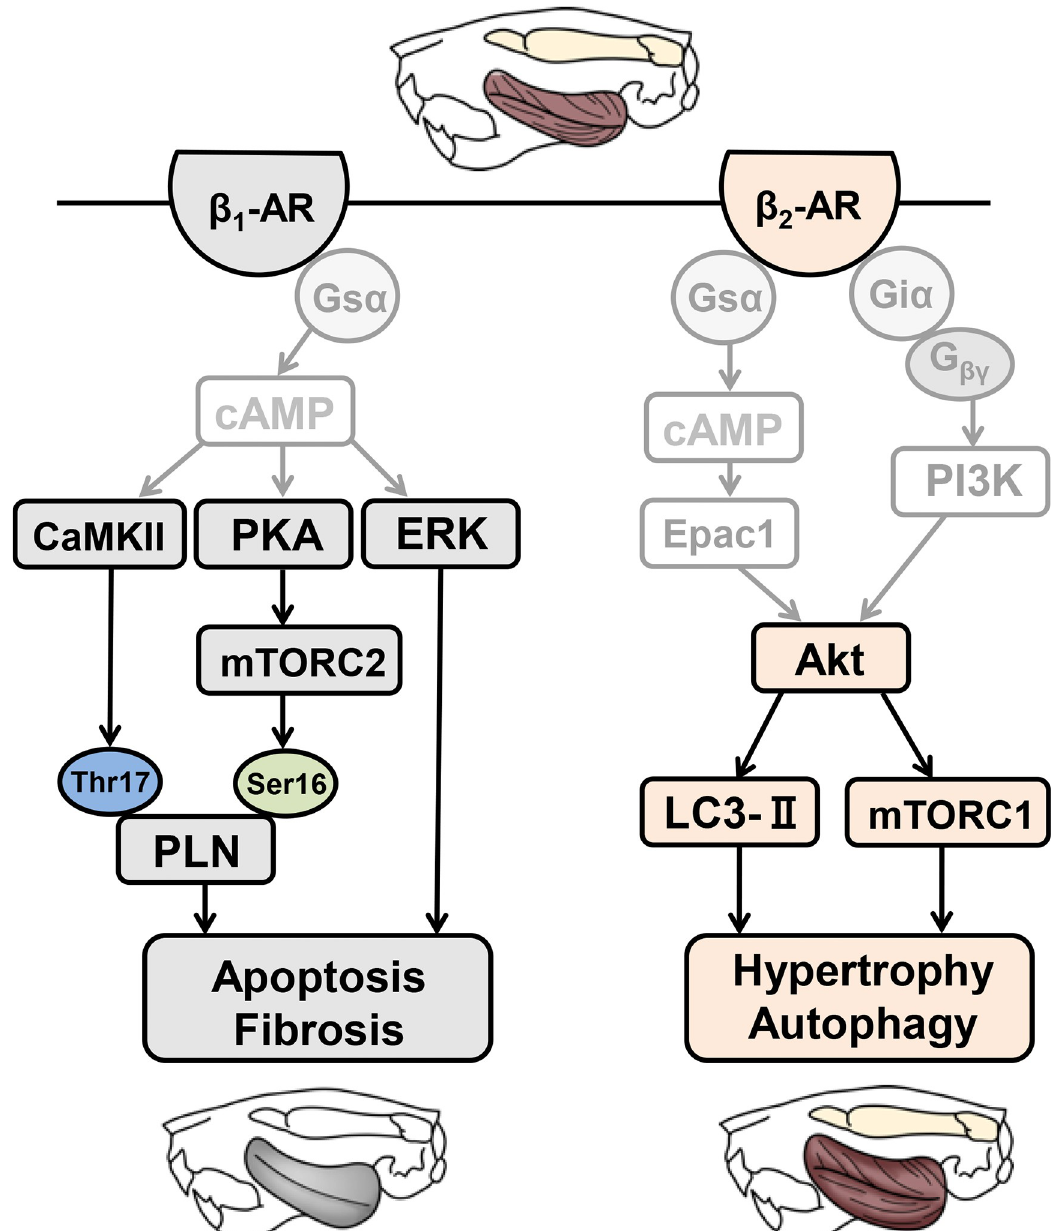
Fig 8. Schematic illustration of the proposed roles of β -AR signaling in masseter muscle. This scheme illustrates the proposed relationship of β 1 -AR and β 2 -AR signaling in masseter muscle. Chronic β 1 -AR stimulation with DOB induces muscle fibrosis and apoptosis with the increase of ERK1/2, CaMKII and mTORC2 activation ( left ). Chronic β 1 -AR stimulation with CB induces muscle hypertrophy and autophagy with increase of mTORC1 activation and LC3-II expression ( right ). Solid black lines represent findings in this study and solid grey lines represents findings reported previously (Lynch et al., 2008 [93], Ohnuki et al. 2014 [11], Ohnuki et al 2016 [12], Okumura et al. 2014